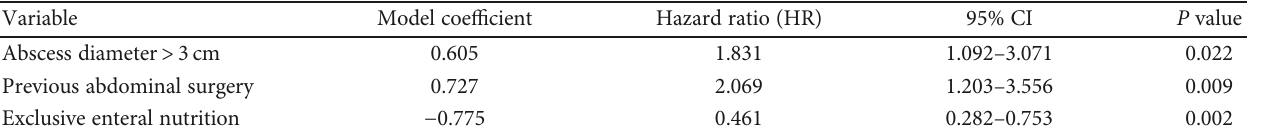
Table 3: Multivariable Cox regression analysis of clinical factors associated with surgery in CD patients with percutaneously undrainable abscesses.